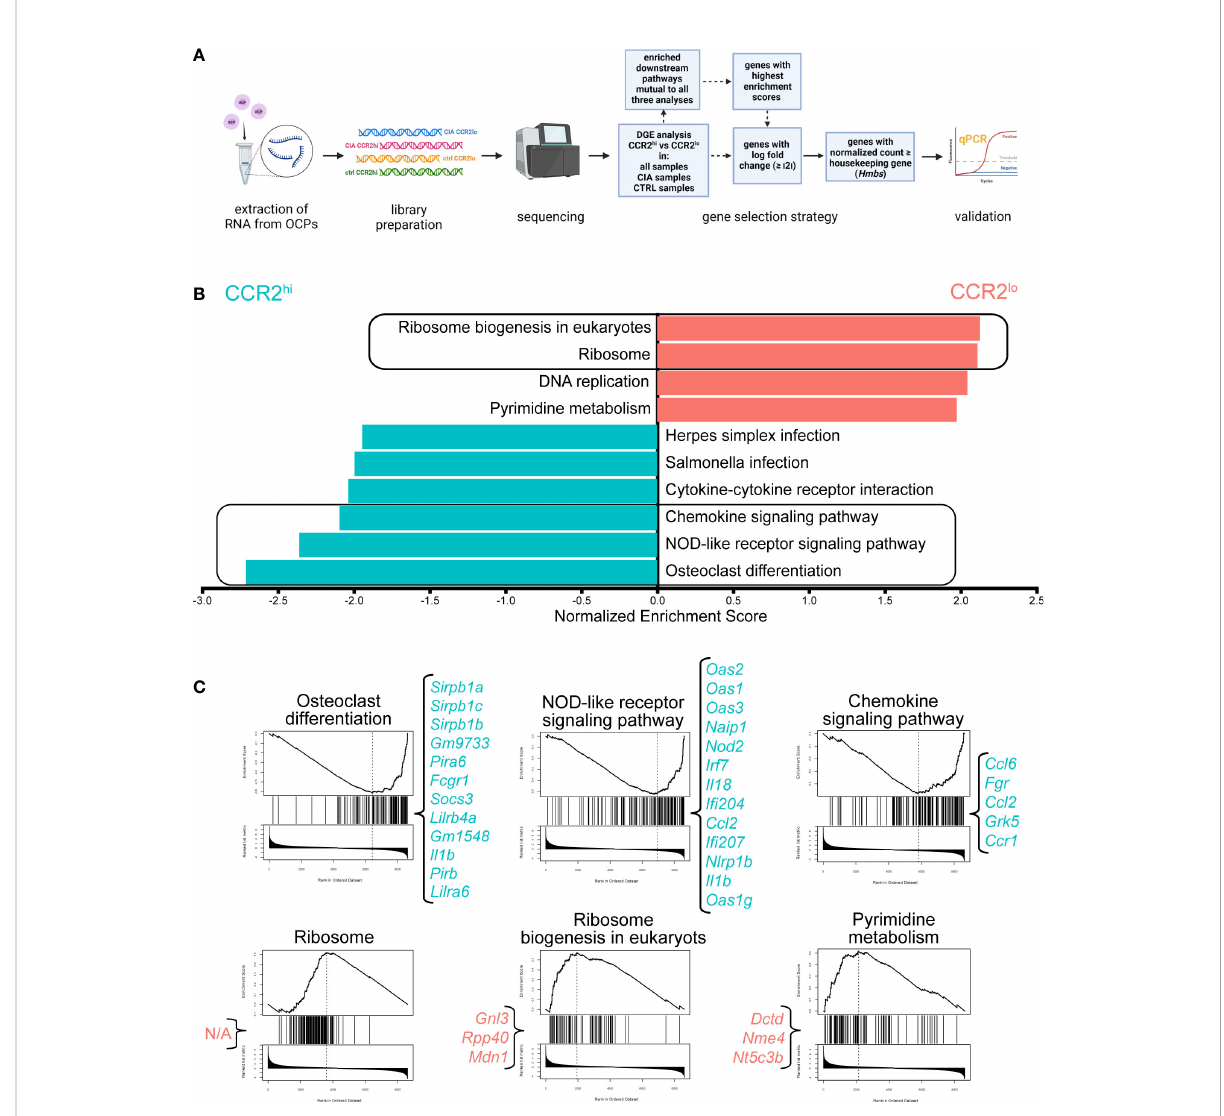
FIGURE 3 Higher expression of osteoclast differentiation, chemokine signaling and NOD-like receptor signaling pathways in CCR2 hi osteoclast progenitor (OCP) subset. (A) Experimental design of RNA sequencing. Sorted OCPs from control (CTRL) mice and mice with collagen-induced arthritis (CIA) were subjected to RNA extraction and library preparation. Differential gene expression (DGE) analysis of the OCP subset (CCR2 hi vs CCR2 lo ) was performed in all samples, only in CIA group, or only in CTRL group, followed by gene set enrichment (GSE) analysis using WebGestalt. The same method was used to compare intervention (CIA vs CTRL) in all samples, only in the CCR2 hi subset or only in the CCR2 lo subset. The criteria for gene selection for qPCR validation is shown in the blue boxes. Created with BioRender.com (B) Downstream pathway analysis showing normalized enrichment scores for signi fi cantly enriched pathways in CCR2 hi (cyan) or CCR2 lo (red) OCP subsets in comparison with gene expression in all samples. Redundancy reduction using weighted set cover was applied to minimize the number of pathways while maximizing gene coverage. False discovery rate was set to <0.05. Framed pathways were also enriched when comparing OCP subsets in only CIA or only CTRL group. (C) GSE plots for OCP subset-characteristic pathways. The line in the top plot represents the running enrichment score for a given pathway as the analysis goes down the ranked list. The value at the peak denotes the fi nal enrichment score. The middle plot shows where the genes related to the pathway are located in the ranking. Genes that appear before the positive enrichment score, or after the negative enrichment score, represent the leading edge subset. The lower plot shows the distribution of the ranking metric along the list of the ranked genes. Genes in the leading edge with highest enrichment scores that fi t the proposed criteria are listed in curly brackets. N/A – non-applicable as none of the genes from this pathway fi t the